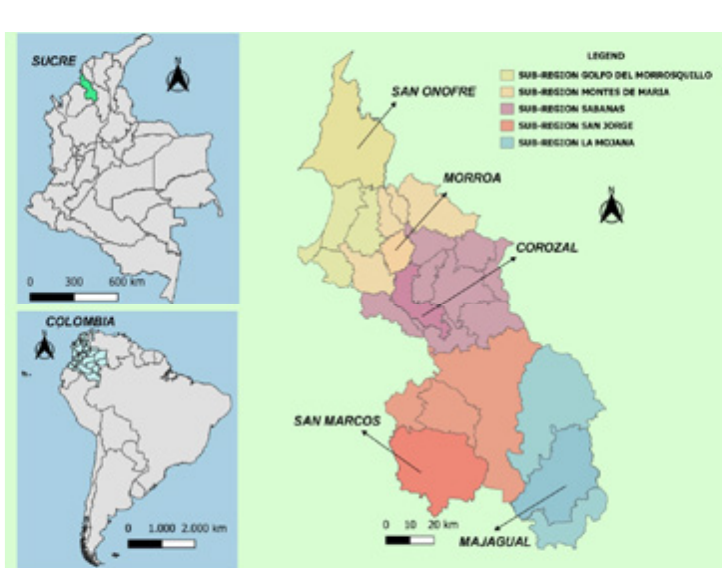
Fig. 1: Geographic location of the study area in the Department of Sucre in Northern Fig. 1 : Geographic l ocation of the study area in the Department of Sucre in Northern Colombia